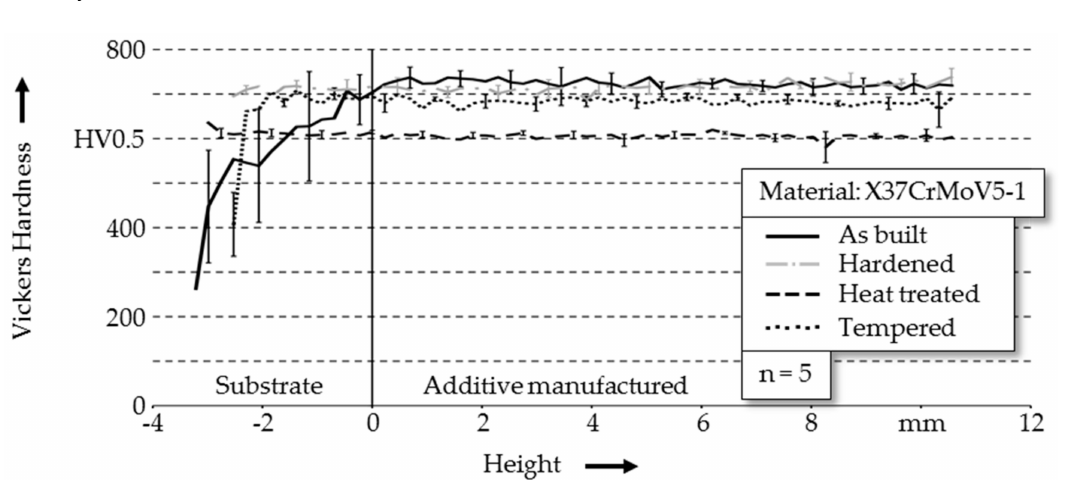
Figure 5. Hardness in z